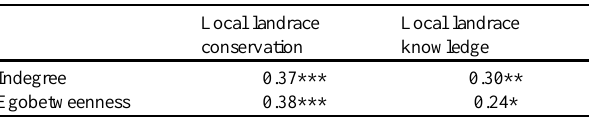
Table 3 . Spearman correlations between individual centrality measures (indegree and egobetweenness) and local landrace conservation and knowledge ( n = 55). For definition of variables, see Table